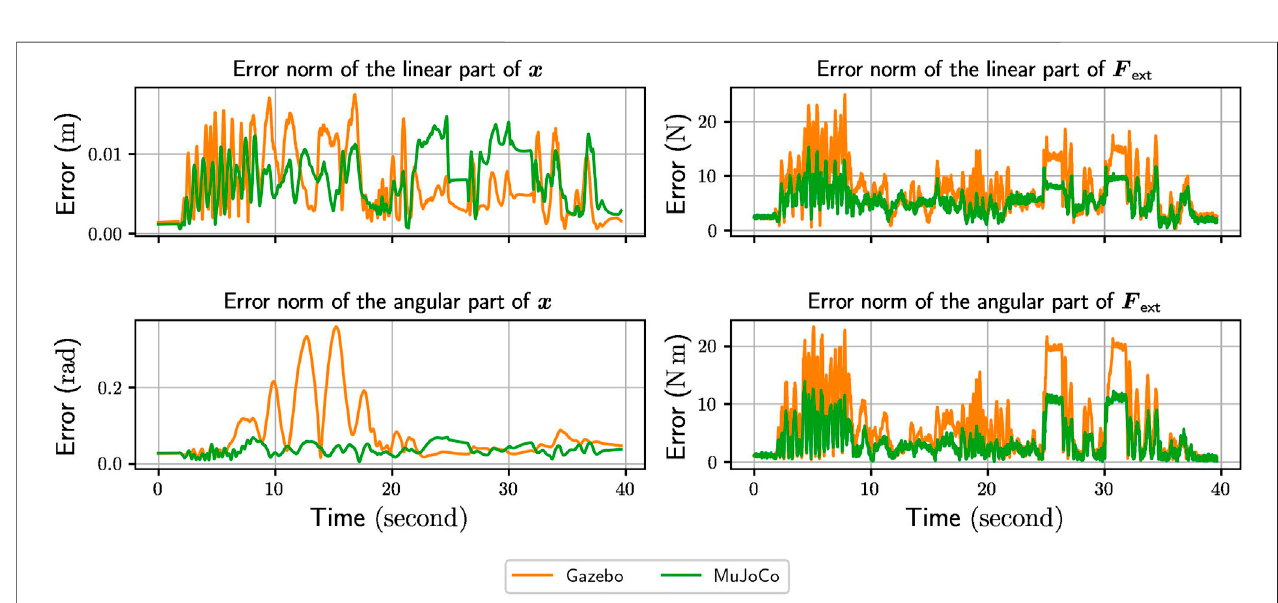
FIGURE 7 | Linear and angular error norms for the pose (left) and external wrench estimate (right) as observed in the second experiment. The model error of the Gazebo implementation is compared to the error of our own digital twin based on MuJoCo, where telemetry from the real system serves as ground truth.